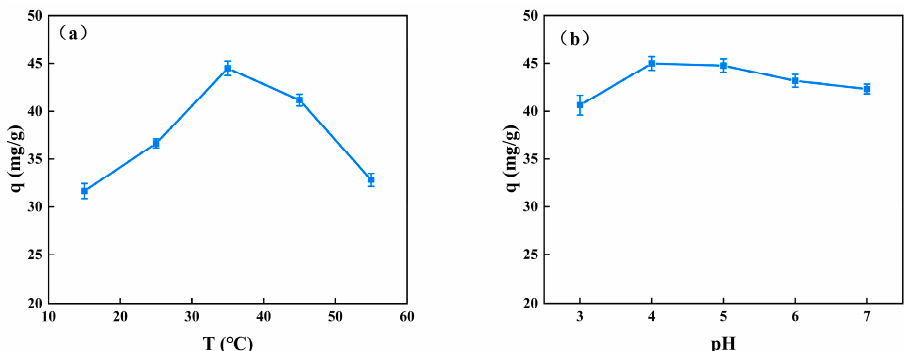
Figure 6. Effects of adsorption temperature and pH on the adsorption capacity of BSA: ( a ) adsorption temperature; ( b ) adsorption pH.